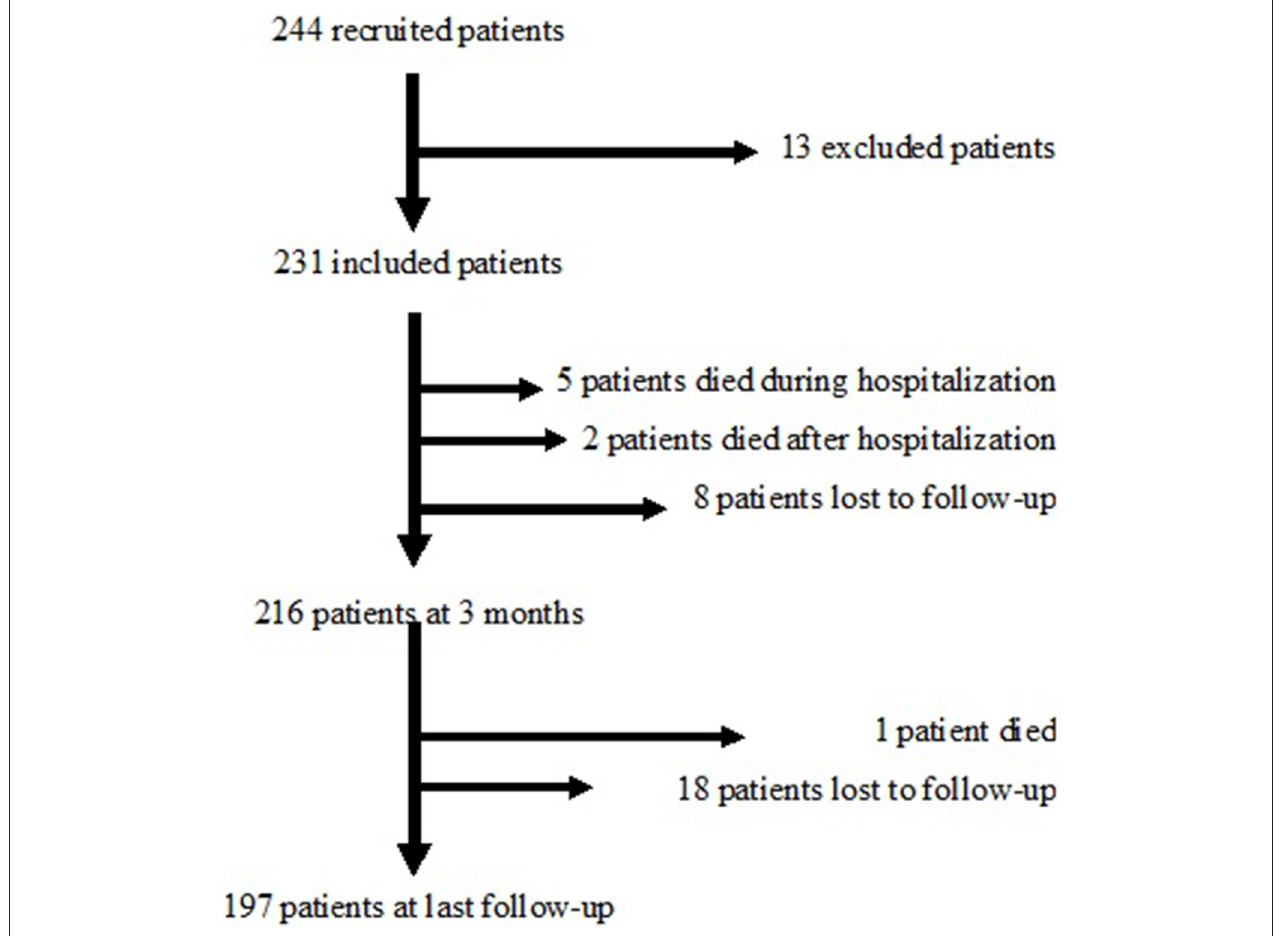
FIGURE 1 | Flow chart of the study.